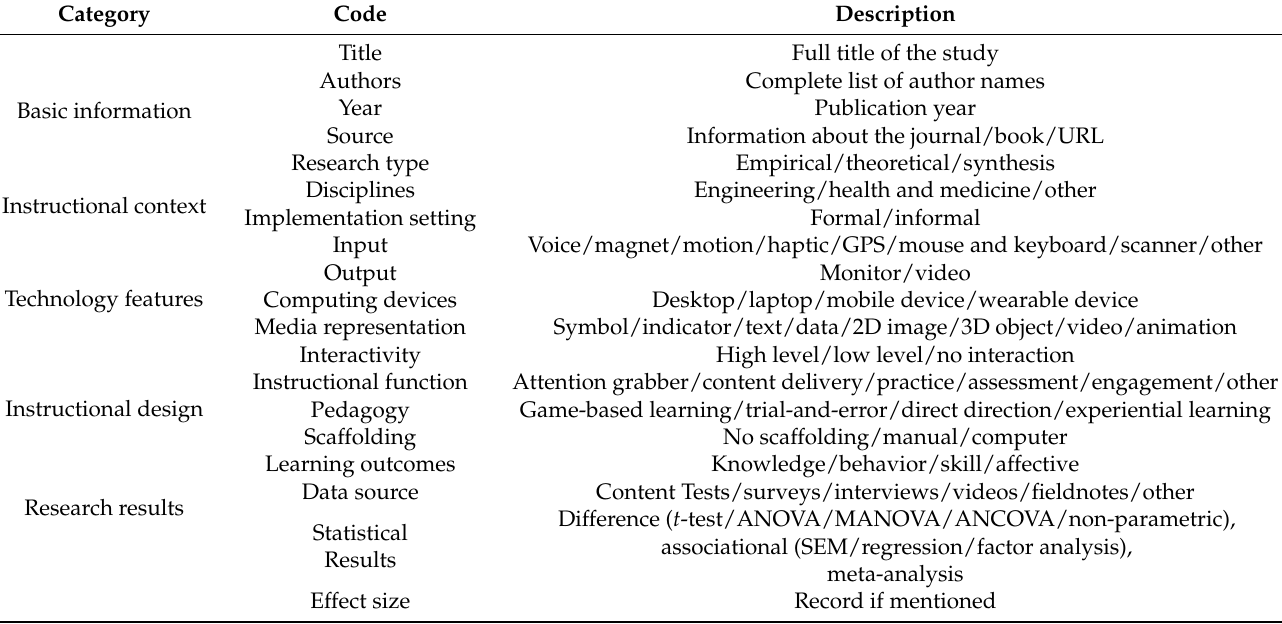
Table 1. Lists of codes for the analysis of selected